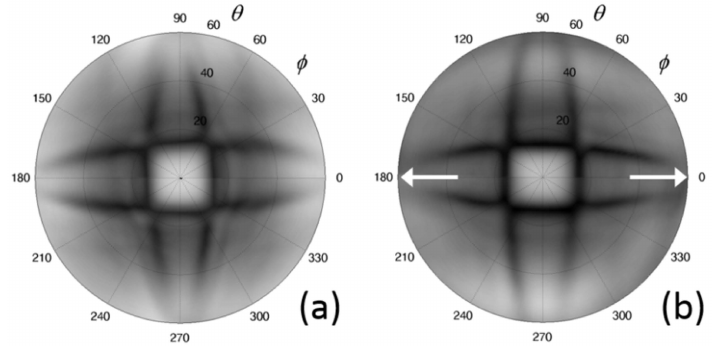
Figure 11. P-UPS recording of woven C/E laminate: before ( a ) and after ( b ) applying tension